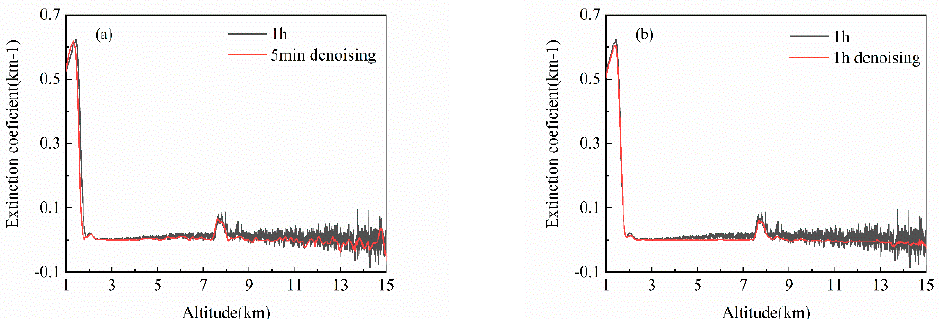
14 of 18 Figure 11. Comparison of aerosol extinction coefficient before and after denoising. 4.6. Comparison with Averaging Signals In daily lidar signal processing, time averaging is often used as an effective denoising method. The longer the average time, the higher the SNR. In order to compare the differ- ence between WT-VMD method and time averaging method, the one-hour lidar signal measured in Heifei from 15:00 to 16:00 on 8 September 2021 is selected as experimental data. The one-hour lidar signal is cumulative averaged and compared with the 5 min sig- nal denoised by WT-VMD. The Figure 12a shows the extinction coefficient results in both cases. The 1 h averaging signal still had a lot of noise after 9 km, while the noise content of the 5 min signal decreased significantly after using WT-VMD. Figure 12b presents the extinction coefficients of 1 h averaging signal before and after denoising. Using WT-VMD to denoise the one-hour averaging signal makes the signal smoother and the signal struc- ture clearer. The experiment demonstrates that the averaging method can only reduce noise to a certain extent, but its noise filtering effect is far less than that of WT-VMD. At- mospheric changes are instantaneous. Using too long averaging time to process signals